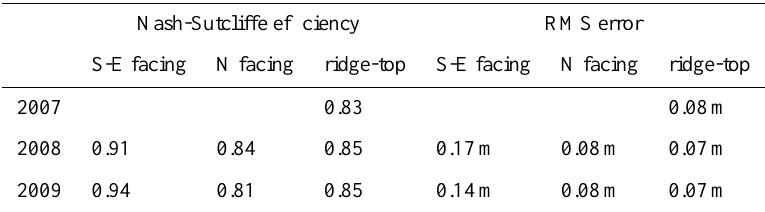
Fig. 3. Comparison of measured and simulated snow depth, SWE, and internal snowpack temperature at (a) south-east facing station, and (b) north facing station during the spring period in 2008. Table 1. Nash-Sutcliffe model efficiency values and RMS errors for snow depth at each site for the period 1 April until final snow disappear- ance during each of the three simulation